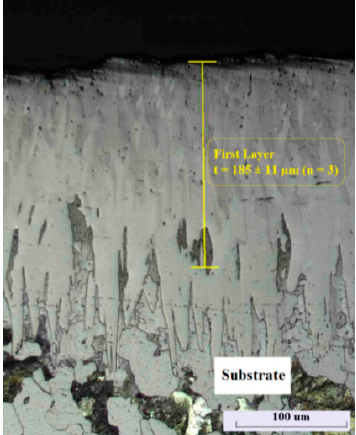
Figure 3. Microstructure image of boronized low carbon steel.